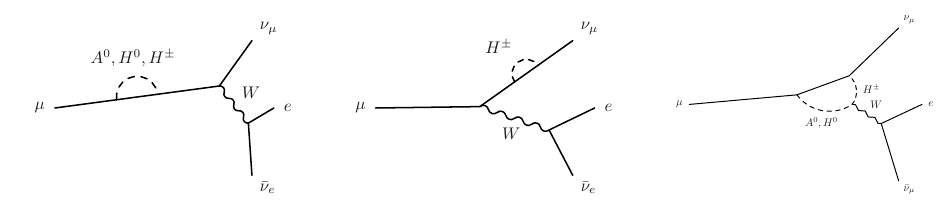
Figure 2 . Leading diagrams for the one-loop correction to the muon